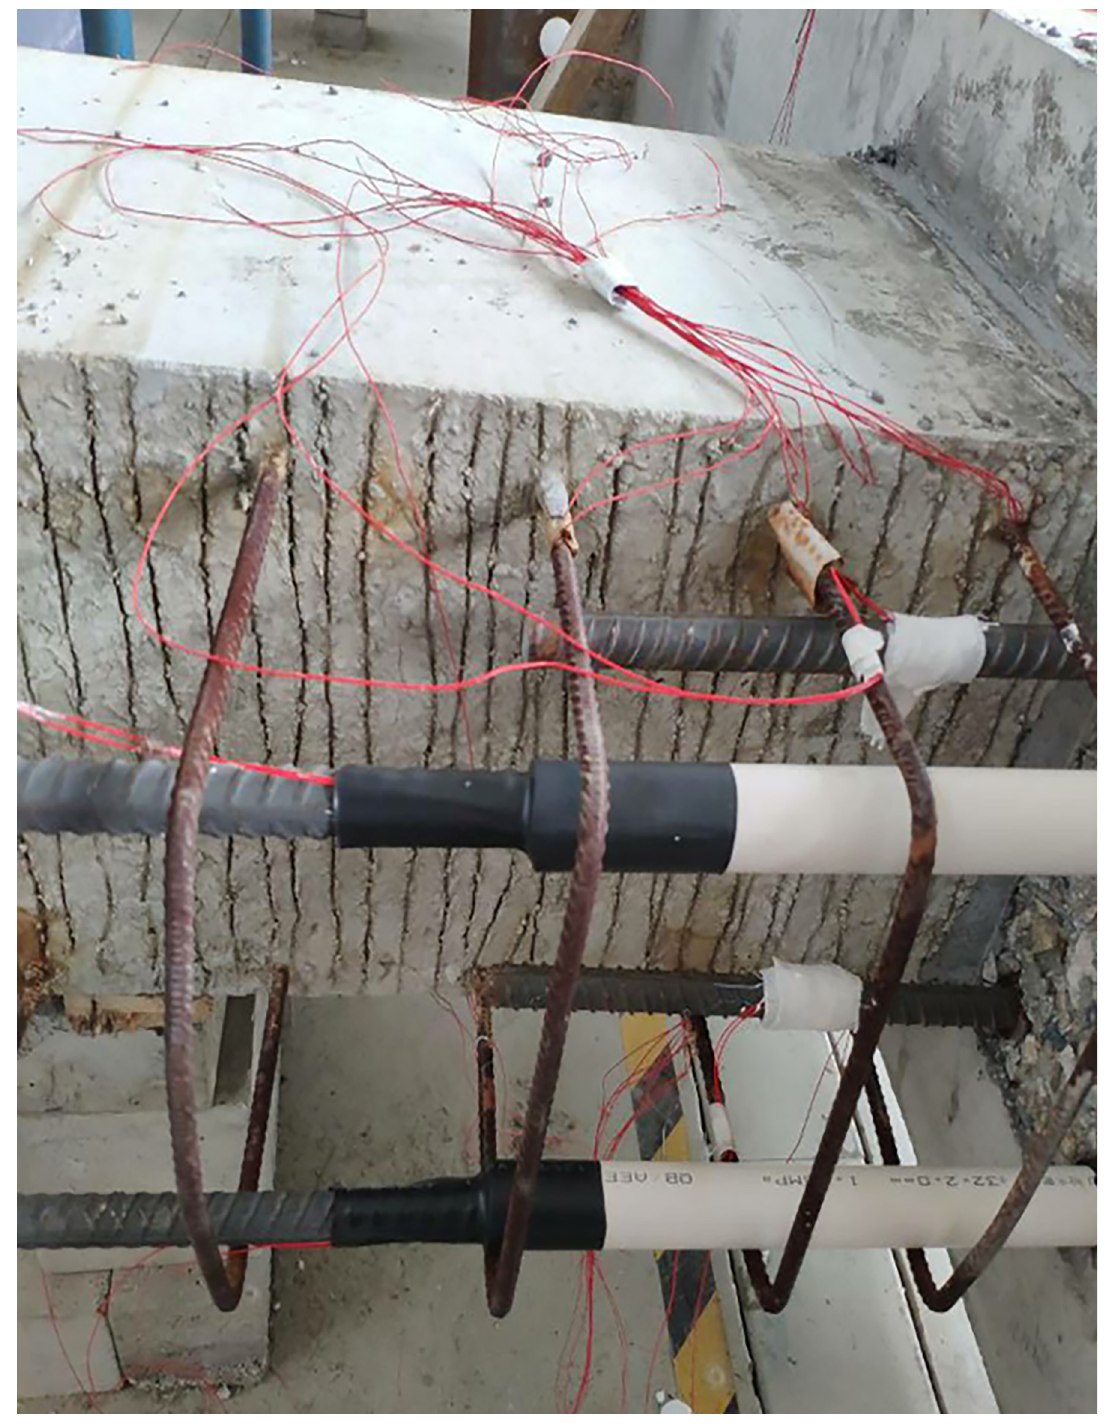
Fig 4. Installing